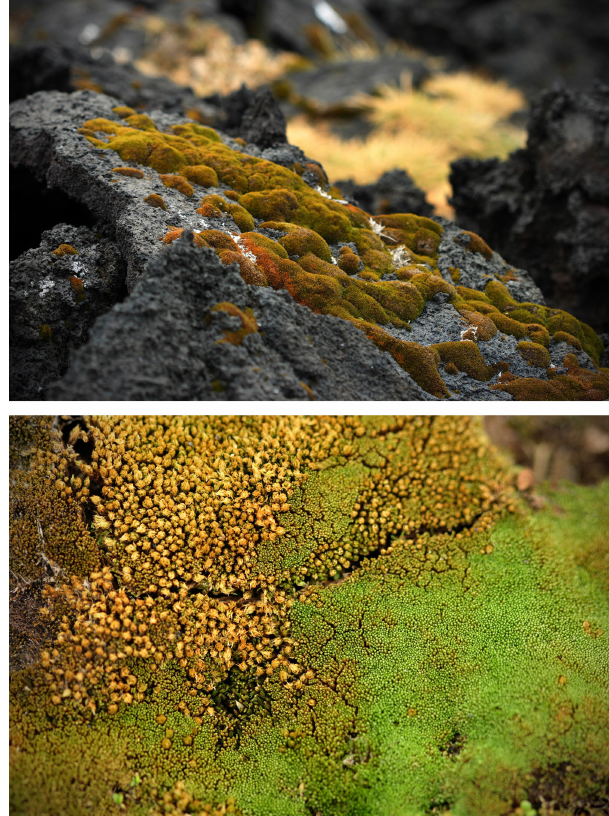
Figure 7. Schistidium spp. (upper image) growing on lava and Bryum spp. (lower image) growing in dense cushions; both within the gull colony. Photos: GVI, 7 July